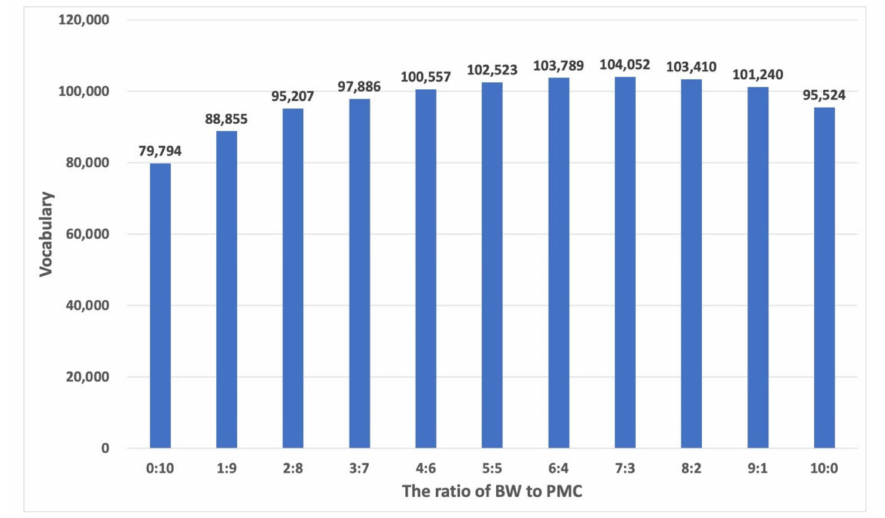
Figure 3. Vocabulary number